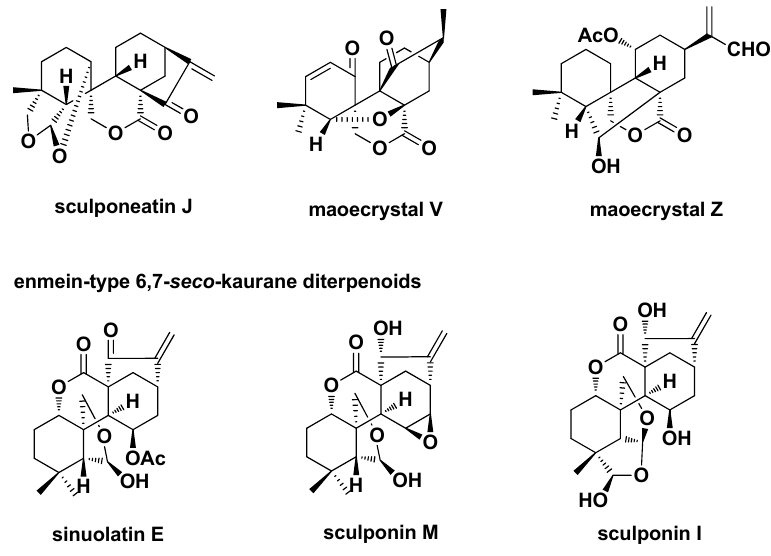
Figure 18. Natural spirolactone- and enmein-type 6,7- seco -kaurane diterpenoids.